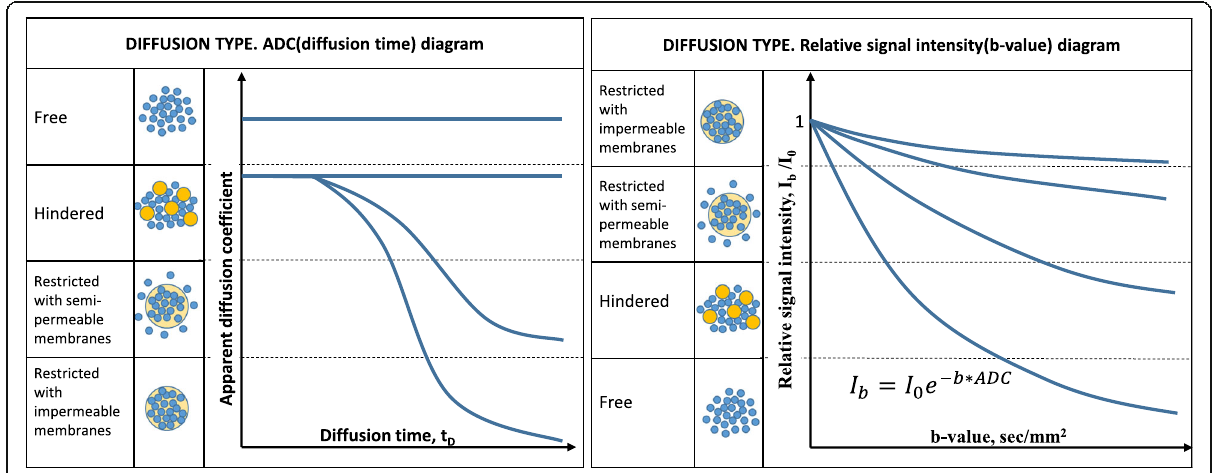
Fig. 3 Four diffusion types: non-restricted, hindered, restricted with semi-permeable, and impermeable membranes: a Apparent diffusion coefficient dependencies of diffusion time. b Relative signal intensity dependencies from b value for different diffusion